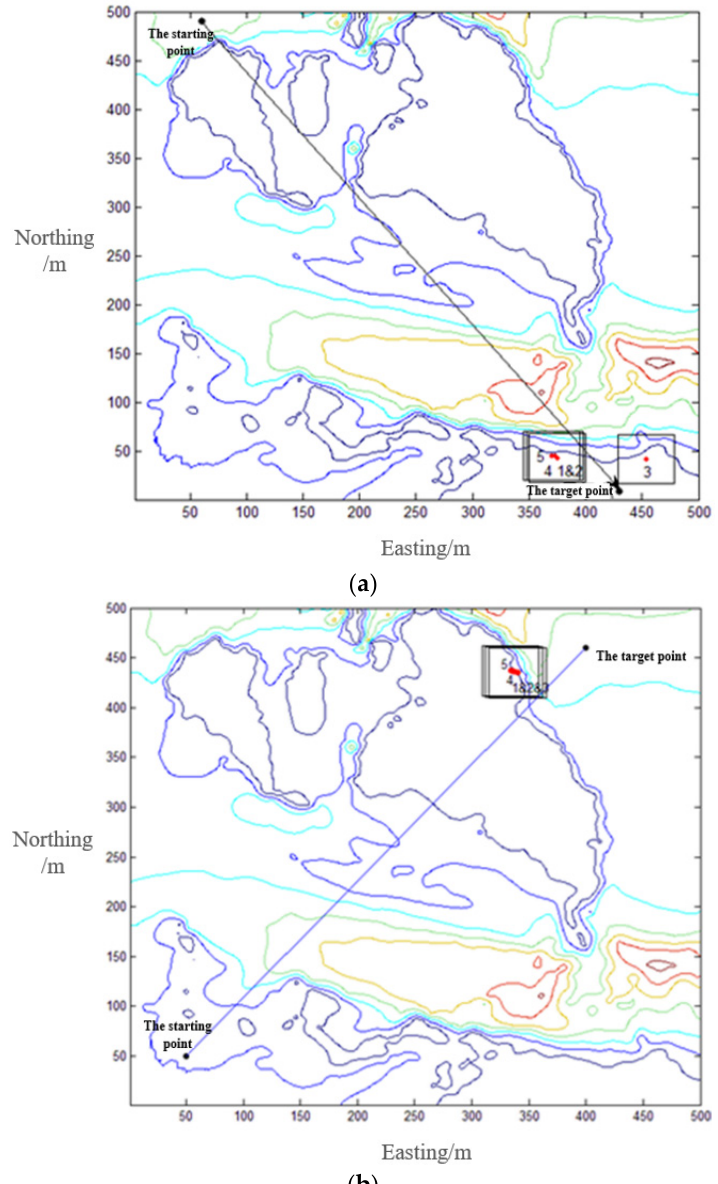
Figure 14. The position of aided area in the contour map. ( a ) The TAN-suitable area with the aided point as its center point in Table 4; ( b ) The TAN-suitable area with the aided point as its center point in Table 5. in Table 5.